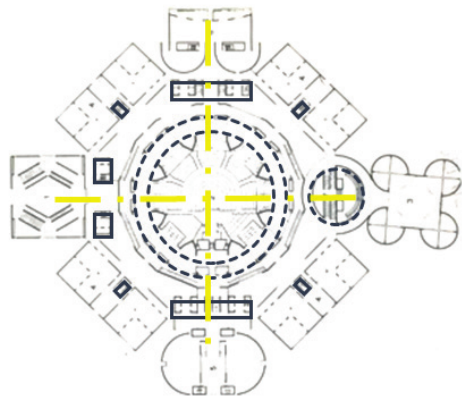
Figure 5. Floor plan of city hall